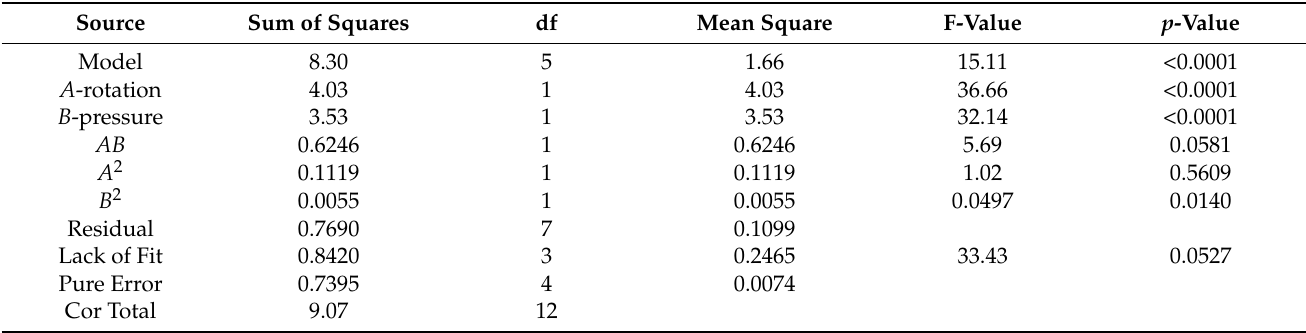
Table 5. Variance analysis of the empty broadcast